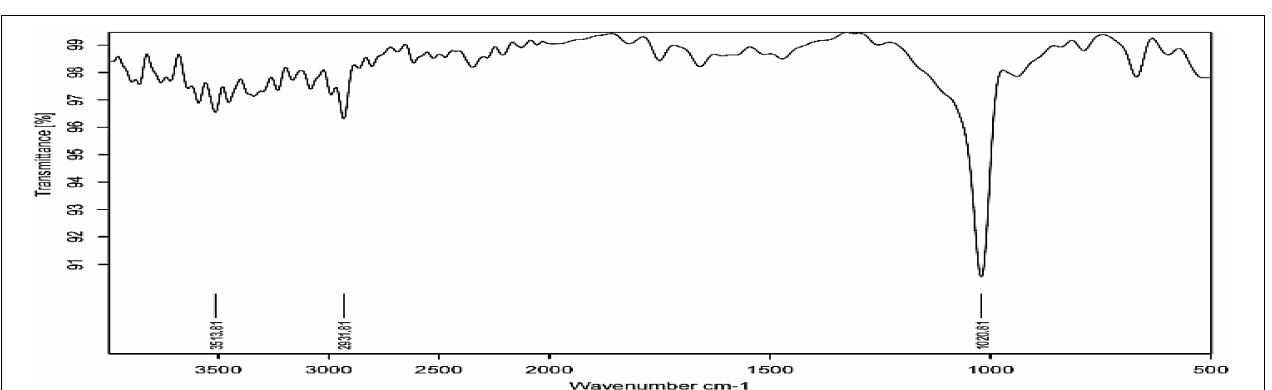
FIGURE 2 | DLS of synthesized zinc nanoparticles.